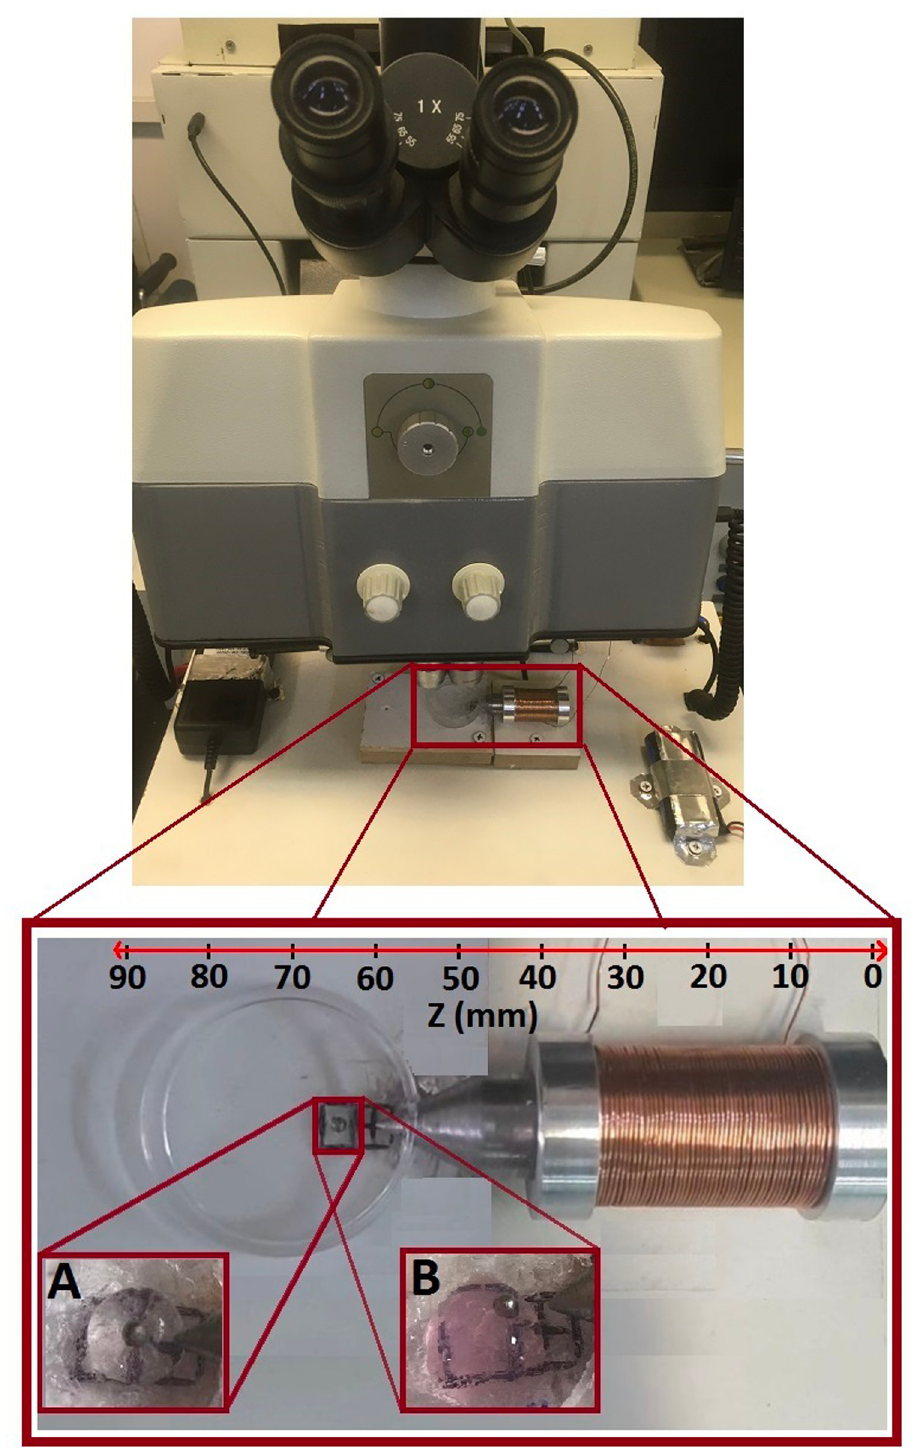
Fig 6. The prepared samples of bead and hydrogels of agarose and collagen, as inset pictures of A and B respectively, within water in the vicinity of the magnetic core tip of AMBR set-up.